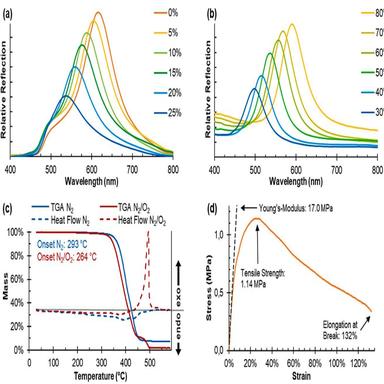
Optical, thermal, and mechanical properties of the optimized polymer compound CSP4. (a) Angle-dependent reflection spectra, illustrating the goniochromic behavior. (b) Strain-dependent reflection spectra, illustrating the mechanochromic behavior. (c) TGA temperature-sweep in N2 and N2/O2 atmosphere with the corresponding heat flow. (d) Tensile test for the determination of mechanical properties.